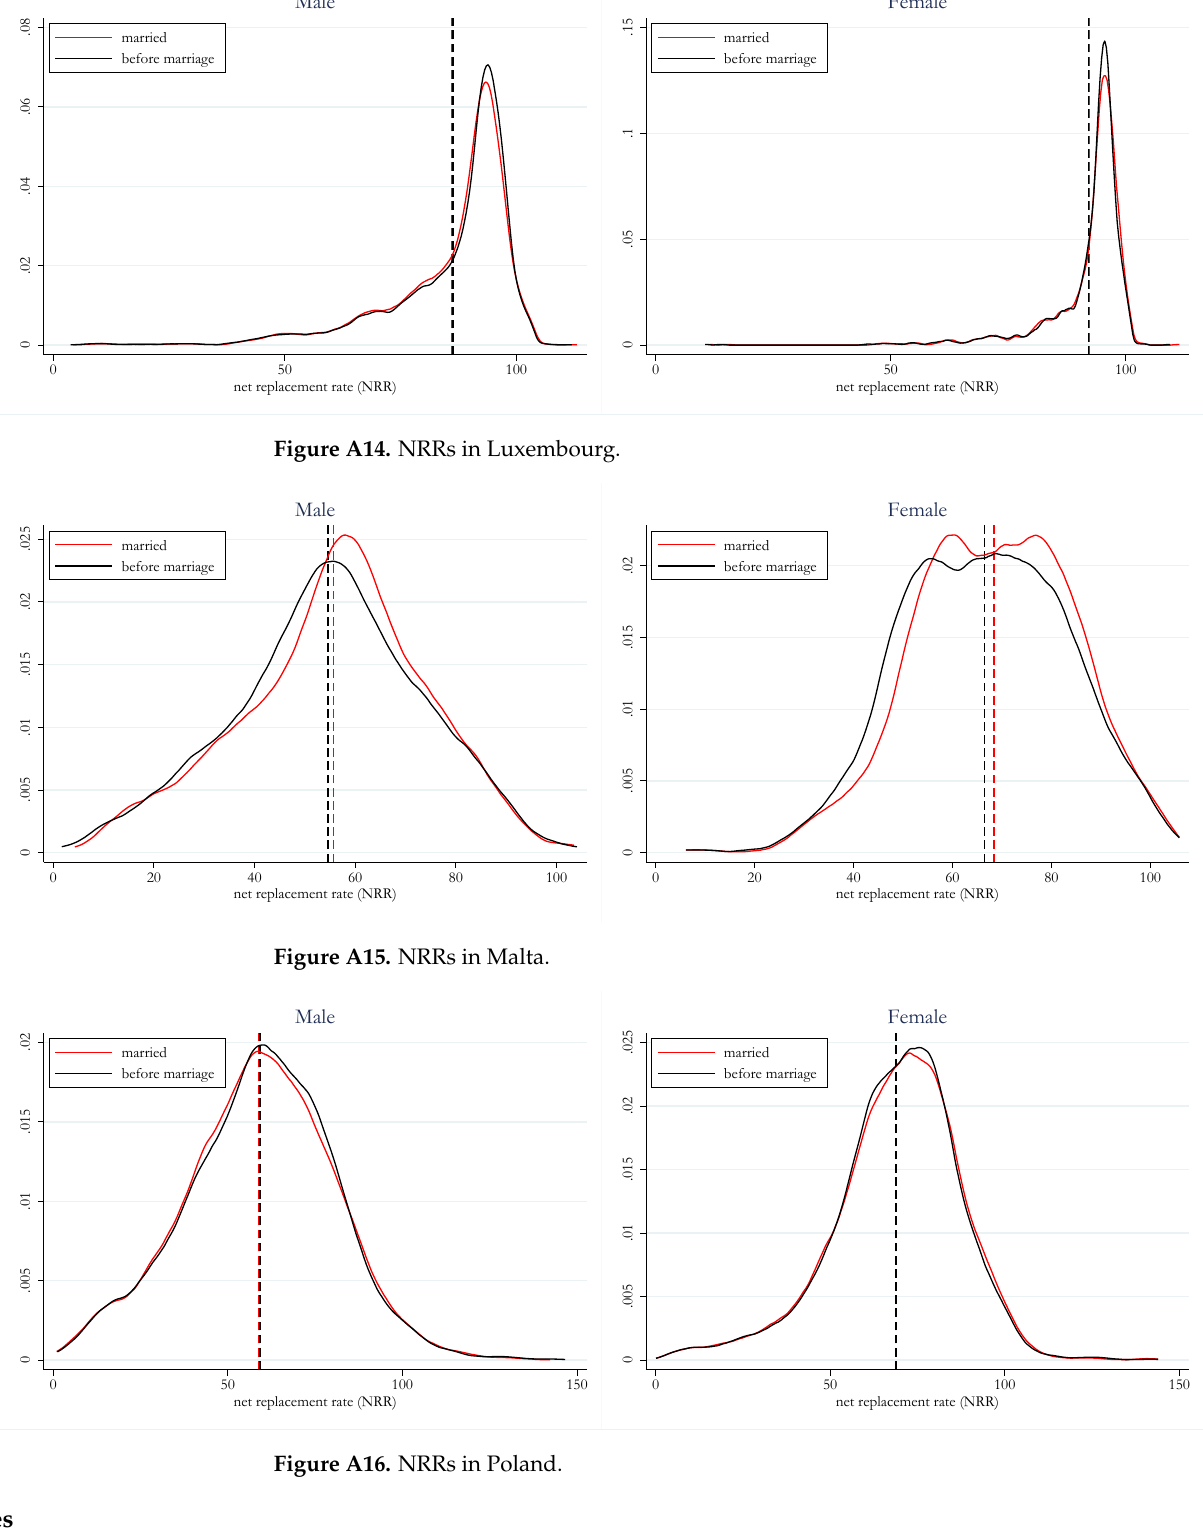
Figure A16. NRRs in